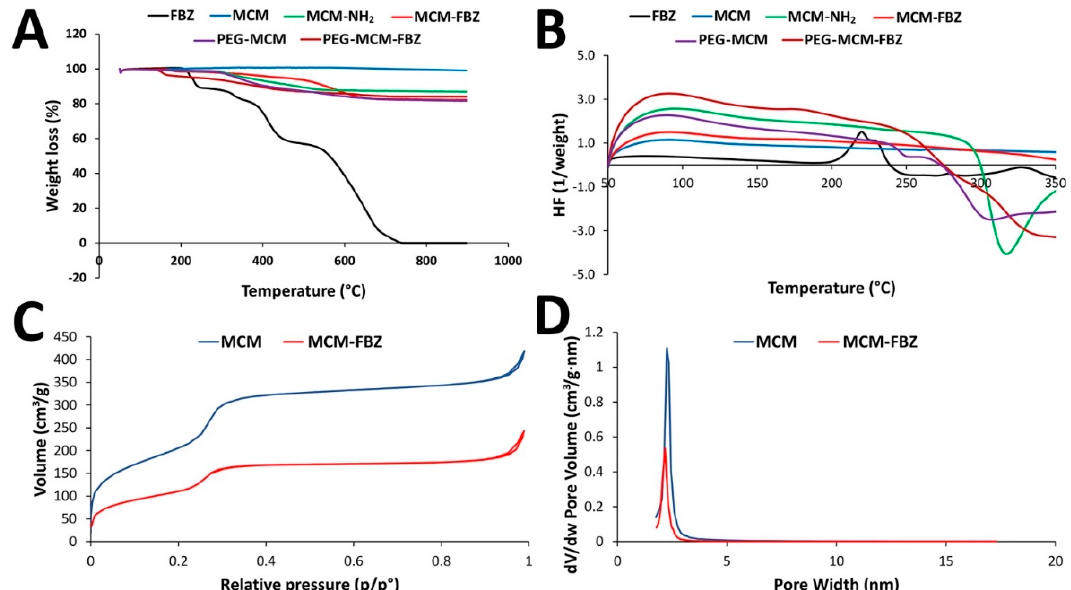
Figure 2. ( A ) TGA thermogram of FBZ, MCM, MCM − FBZ, MCM − NH 2 , PEG − MCM, and PEG − MCM − FBZ NPs; ( B ) DSC thermogram of FBZ, MCM, MCM − FBZ, MCM − NH 2 , PEG − MCM, and PEG − MCM − FBZ NPs; ( C ) N2 adsorption–desorption isotherms, and ( D ) pore size distributions of MCM and MCM − FBZ NPs using the BET method.